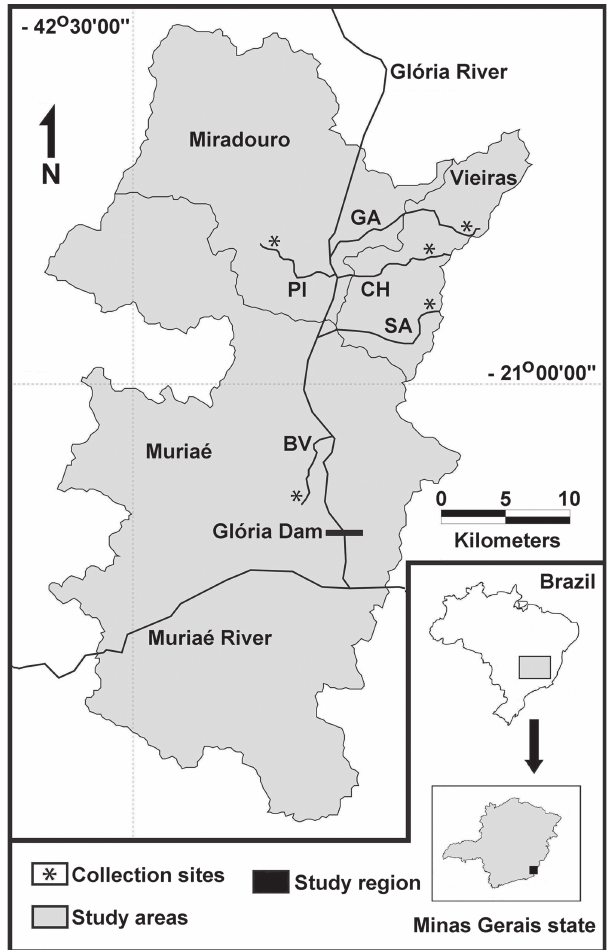
Fig. 1. Sampling locations of Poecilia and Xiphophorus